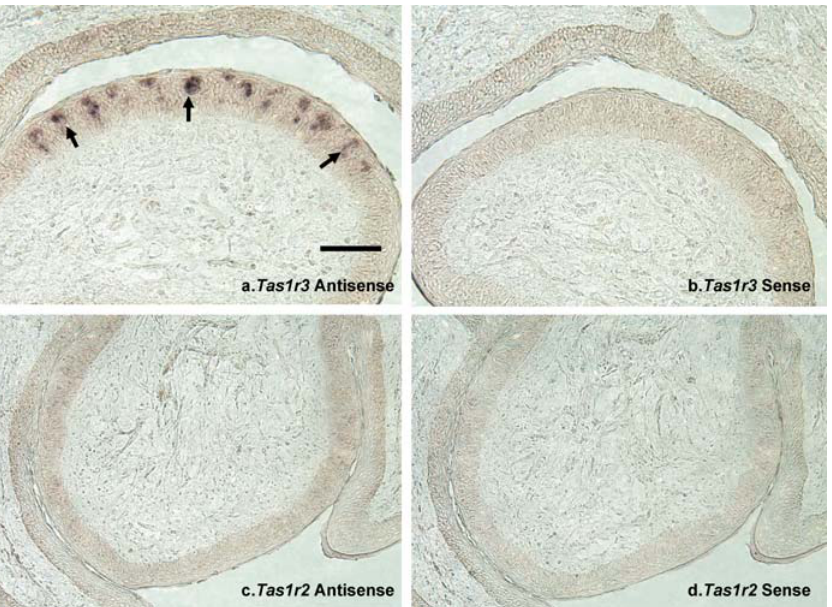
Figure 3. RNA Expression of Cat Tas1r2 and Tas1r3 from Circumvallate Papillae Digoxigenin-labeled sense and antisense cRNA probes corresponding to exons 3 and 6 of cat Tas1r2 and Tas1r3 were synthesized using DIG RNA labeling kit (Roche Applied Science, Indianapolis, Indiana, United States) (See Figure 2 for the locations of in situ probes, and Table 3 for identity of primers.) Hybridizations were carried as described [39]. Panel (A) shows result of antisense probes for Tas1r3 , whereas panel (B) shows the result of the sense probes for Tas1r3 . Panel (C) shows results of the antisense probes for Tas1r2 whereas panel (D) shows results of the sense probes. Scale bar, shown only in panel (A), = 60 l m for (A), (B), (C), and (D). DOI: